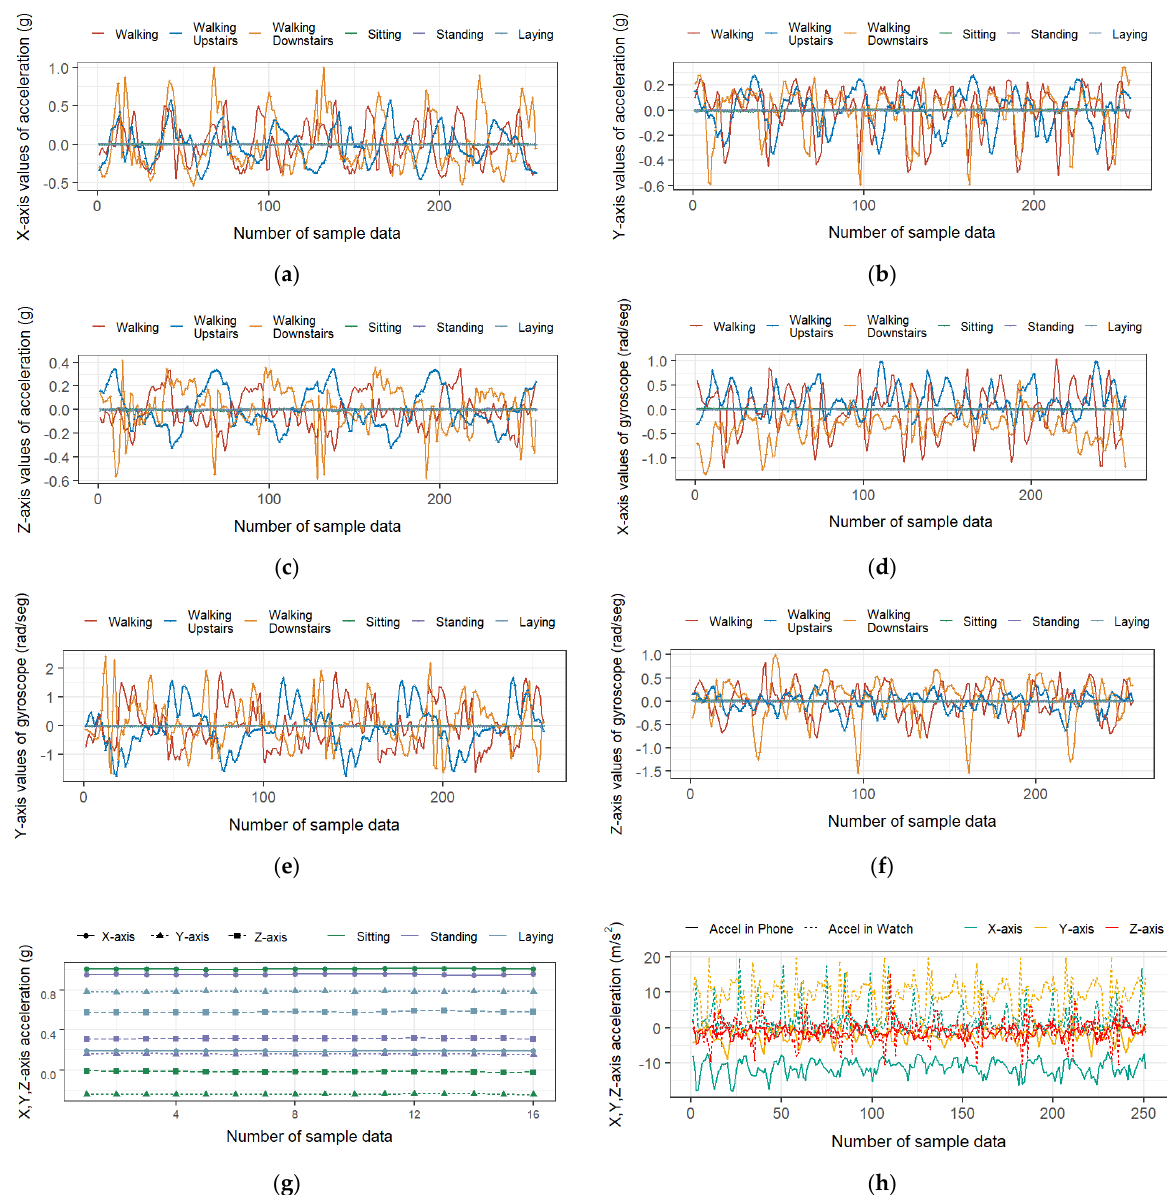
Figure 2. Data samples from accelerometers and gyroscopes. ( a – f ) The X , Y and Z -axis linear acceleration data and angular rate data in the UCI-HAR dataset; ( g ) the X , Y and Z -axis values of total acceleration including gravity when performing sitting, standing and laying in the UCI-HAR dataset; ( h ) the X , Y and Z -axis values of acceleration both from the smartphone and smartwatch when performing walking in the WISDM